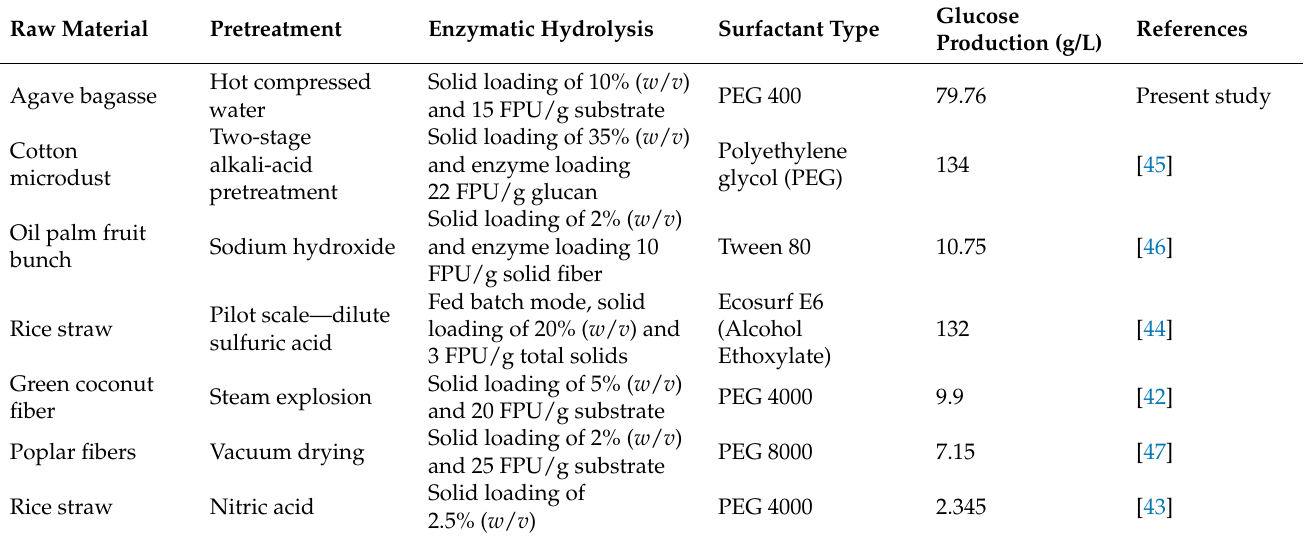
Table 6. Enzymatic hydrolysis and glucose production of different lignocellulosic biomasses using different pretreatments strategies and